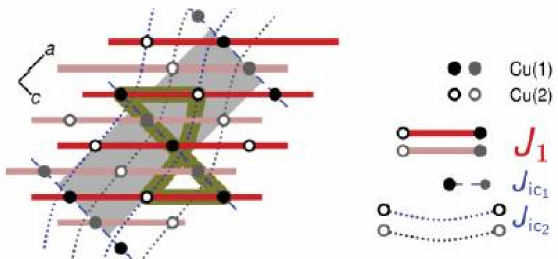
Figure 7. Spin model for CaCu 2 (SeO 3 ) 2 Cl 2 . Filled and empty circles show the Cu(1) and Cu(2) positions, respectively. Bold lines and circles denote atoms in the front plane, whereas gray circles and shaded lines correspond to the atoms lying in the back plane. The planes are connected by Jic1 couplings only. A closed loop (bold line) having an odd number of AFM couplings indicates that the spin model is frustrated. The unit cell is depicted by the gray rectangle. Reprinted figure with permission from [28] Copyright (2011) by the American Physical Society.